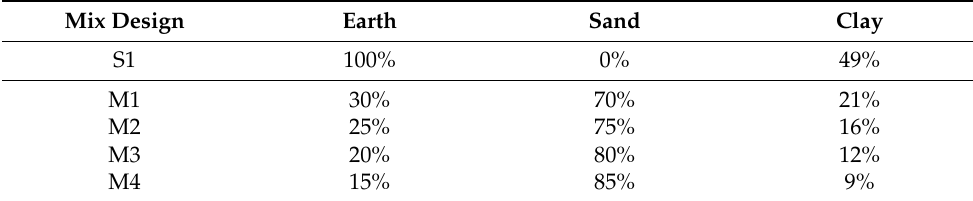
Table 7. Compositions of mortars